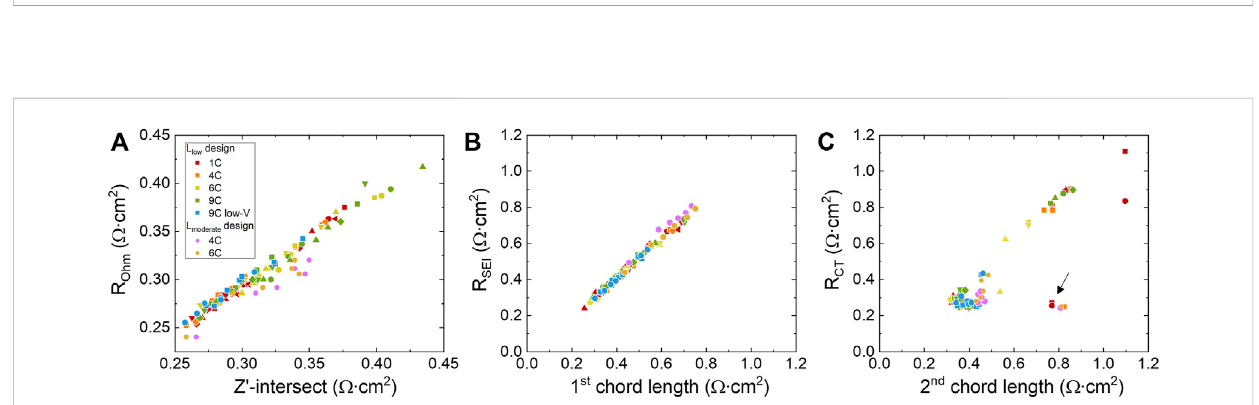
FIGURE 6 Correlations between the fi tted geometric features and resistance components obtained using equivalent circuit fi tting as (A) R Ohm , (B) R SEI , and (C) R CT . The charge protocols and individual cells are marked by different colors and shapes, respectively. The Z ʹ -intersect and fi rst chord length progresses proportionally with R Ohm and R SEI . For R CT , the correlation between the second chord length is not as obvious when R CT < 0.4 Ω . When R CT > 0.4 Ω , the proportional relationship becomes apparent. The outliers, which are data points from early stages of aging (0 or 25 cycles), are marked by the black